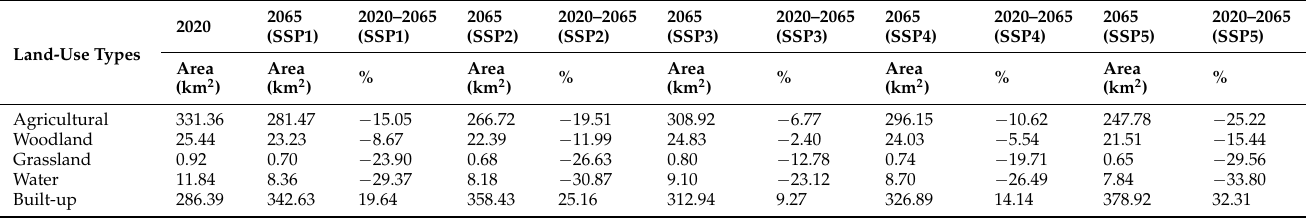
Table 4. Areas assigned to different land uses and the percent change in land-use area over the